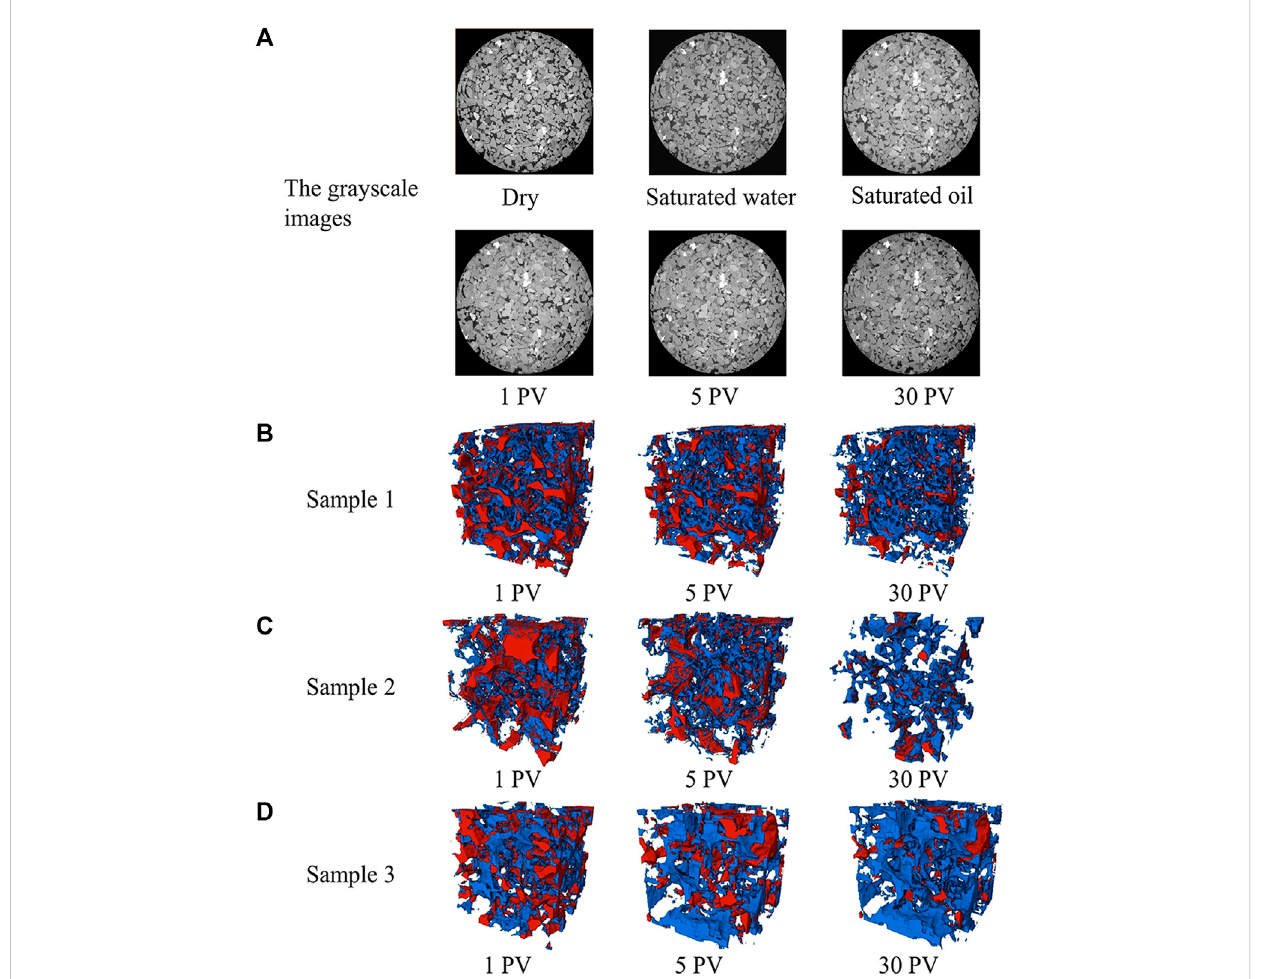
FIGURE 2 (A) GrayscaleimagesofSample1,includingthecomparisonoftheCTgrayscaleimagesofthedrycore,saturatedformationwater,saturatedoil,and different stages of fl uid displacement. (B) Visualization of the oil – water distribution in Sample 1, including the oil (red) and water (blue) phases in water fl ooding at 1 PV, 5 PV, and 30 PV. (C – D) Visualizations of the oil – water distributions in samples 2 and 3,